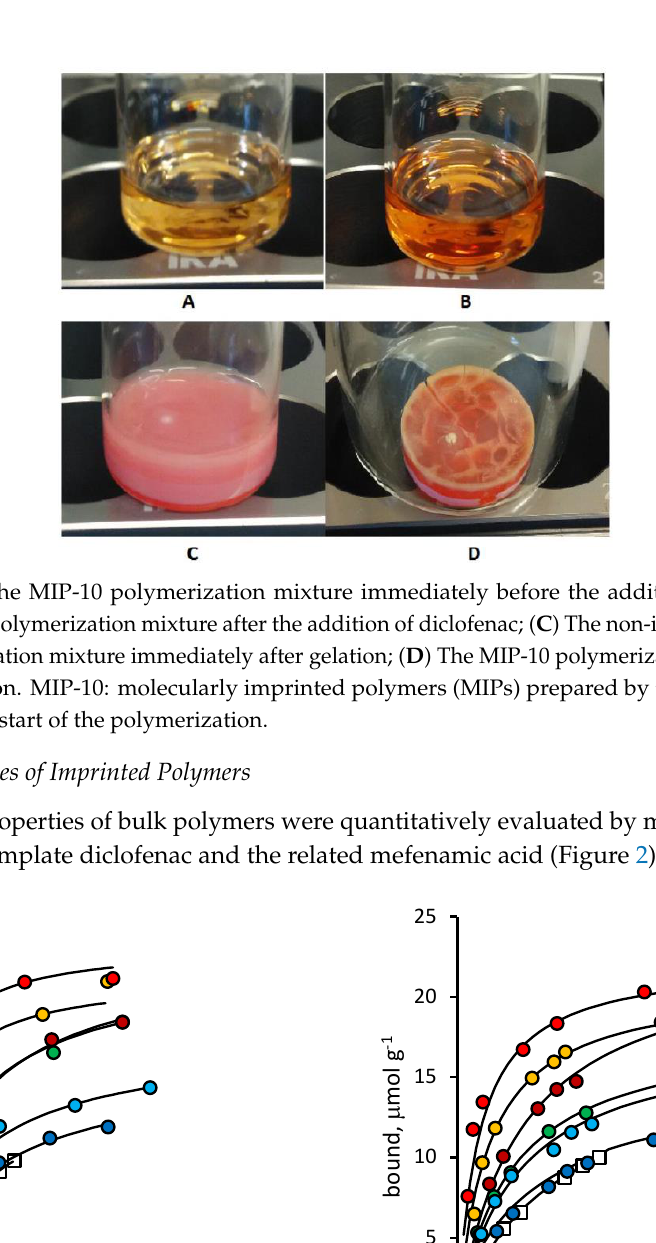
Figure 1. ( a ) The MIP-10 polymerization mixture immediately before the addition of diclofenac; ( b ) The MIP-10 polymerization mixture after the addition of diclofenac; ( c ) The non-imprinted polymer (NIP) polymerization mixture immediately after gelation; ( d ) The MIP-10 polymerization mixture after complete gelation. MIP-10: molecularly imprinted polymers (MIPs) prepared by template addition 10 min from the start of the polymerization.